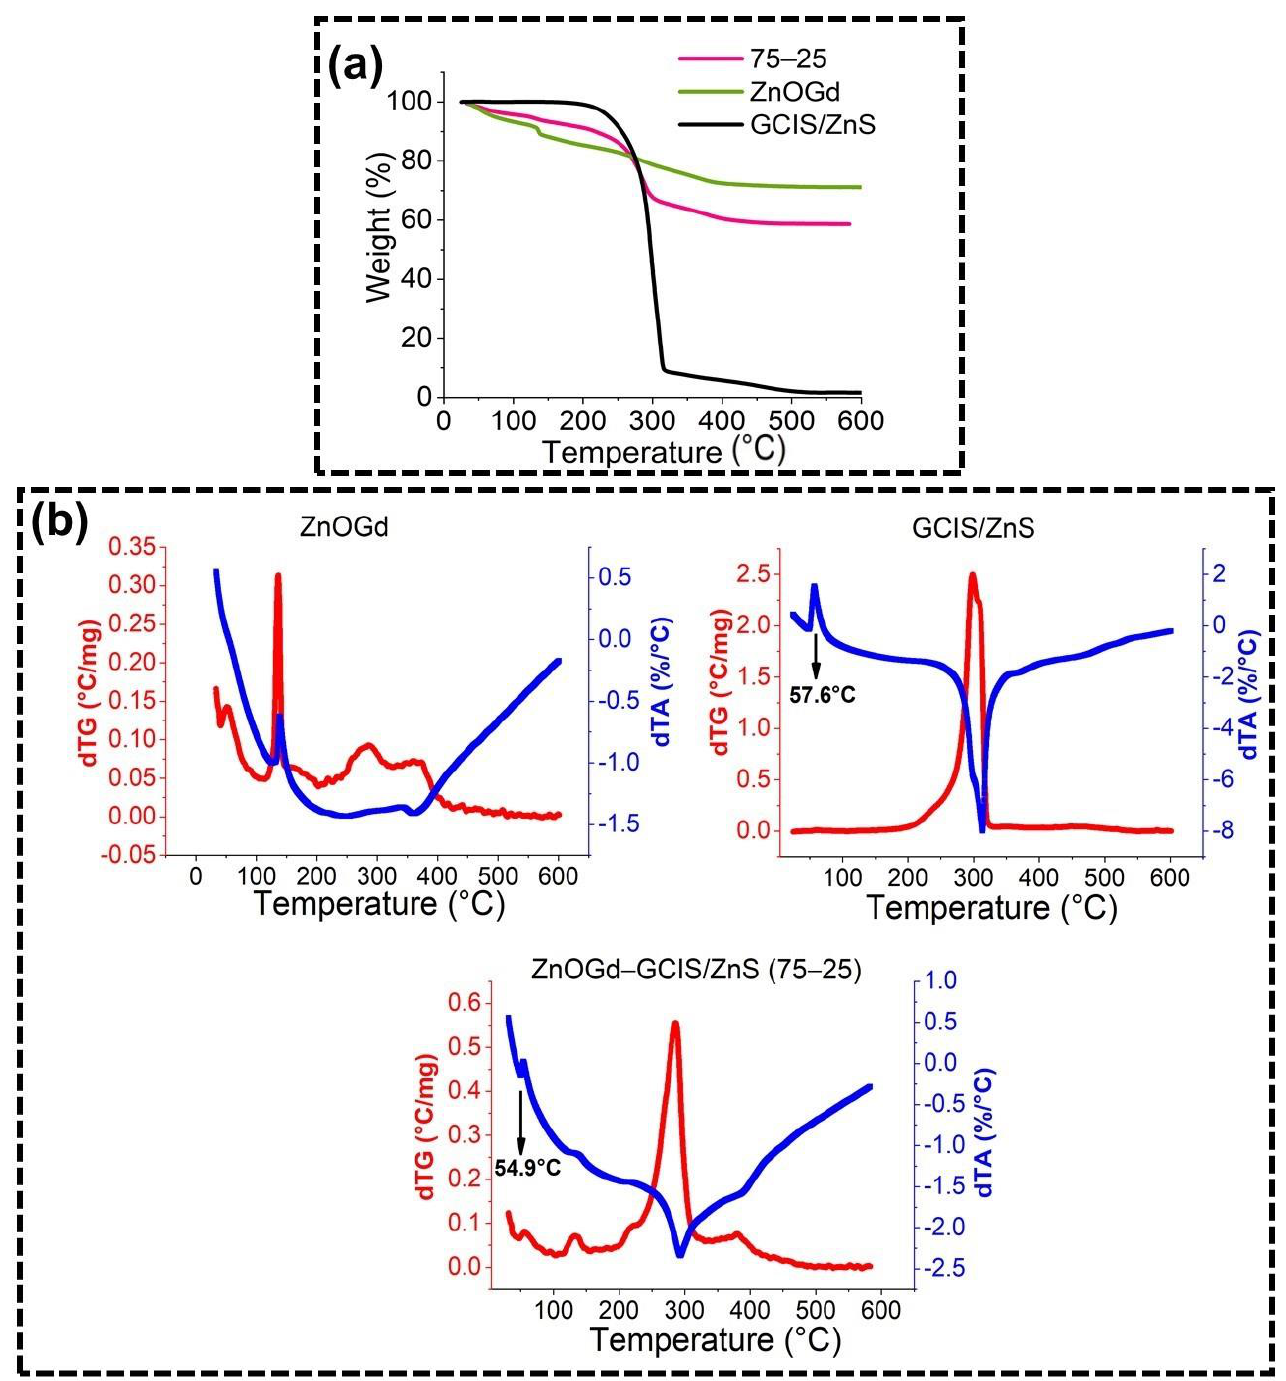
Figure 5. Thermogravimetric analyses of ZnOGd, GCIS/ZnS and ZnOGd-GCIS/ZnS (75-25) ( a ) and their respective DTA and DTG ( b ).